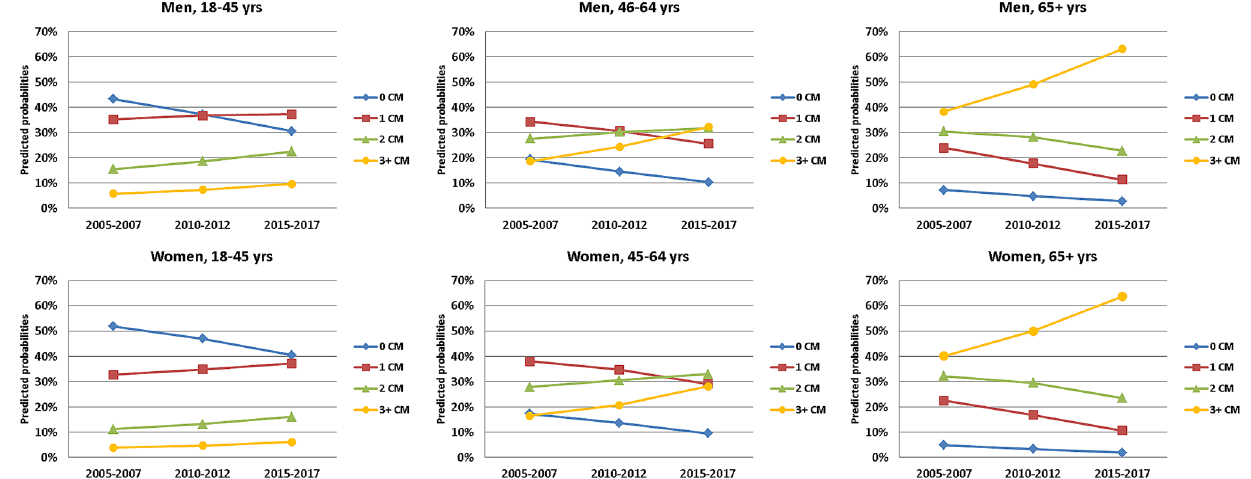
Figure 1. Predicted probabilities of the number of comorbidities in T2D over time period, stratified by age and gender. CM